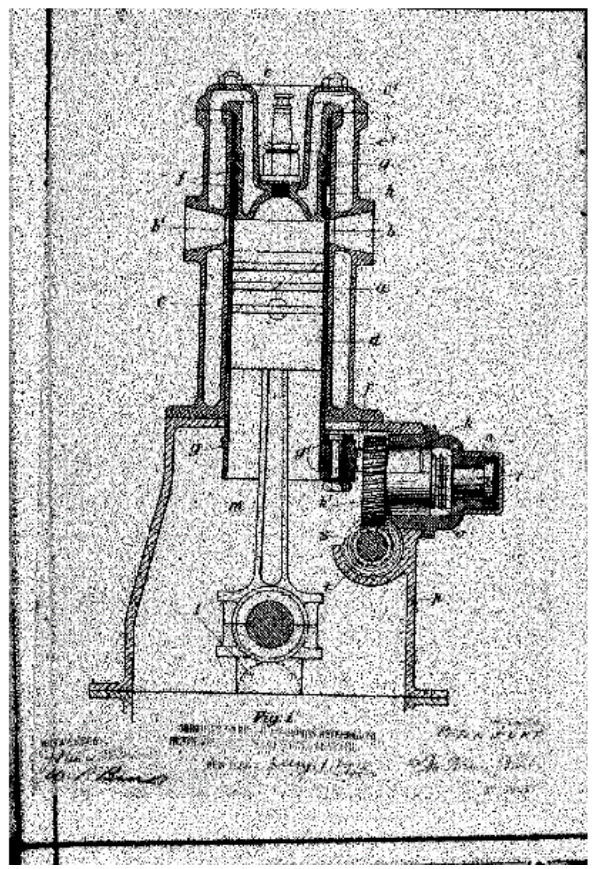
Figure 4. Peter Burt, Argyll Limited, 5 August 1910, an improved internal combustion engine CA 133050A. Reproduced with permission from US Patent Office, Copyright Publisher, 1910.